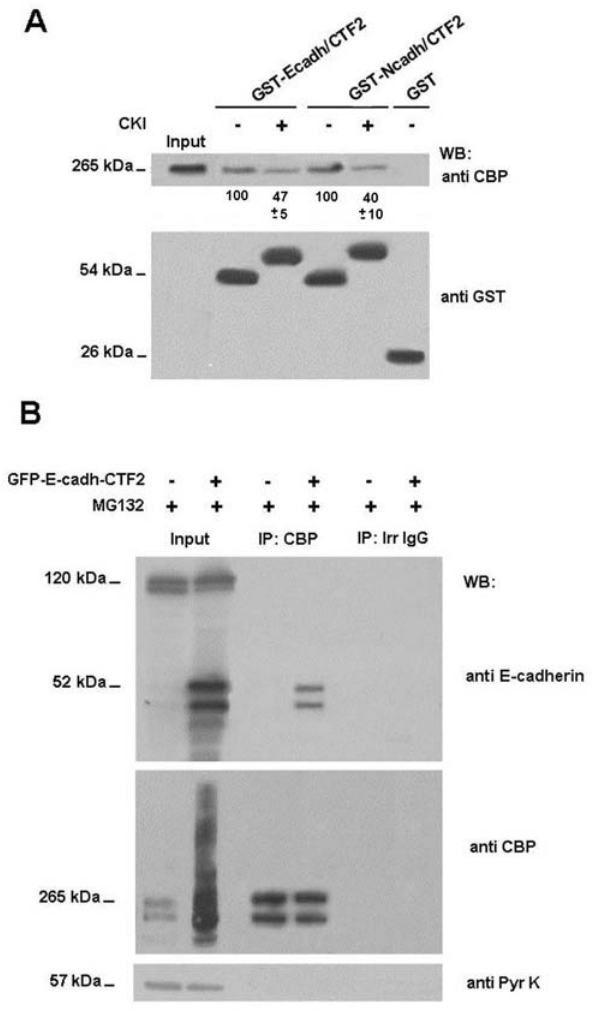
Figure 7. The CTF2 fragment of E-cadherin interacts with CBP. (A) GST-E-cadh-CTF2 and GST-N-cadh-CTF2 were phosphorylated with CKI d , as described in Material and Methods . 20 pmols of non-phosphorylated or phosphorylated GST-cadh-CTF2 proteins, or GST as a control, were incubated with 1.2 mg of MEF PS ( 2 / 2 ) total cell extracts. Protein complexes were affinity-purified with glutathione-Sepharose and ana- lyzed by SDS-PAGE and Western blotting with anti-CBP and anti-GST, to ensurethat similar levels offusionproteinswerepresent inall cases.Inthe Input lane,a sample correspondingto5%of the total cell extracts usedfor the assay was loaded. Autoradiograms were scanned and the average of CBP bound with respect to the value obtained without CKI is shown below the western blot (average + / 2 S.D. of three experiments). (B) MEFs PS ( 2 / 2 ) were transfected with 7 m g of GFP or E-cadh-CTF2-GFP, to simulate the CTF2 fragment present in MEF PS1/PS2 ( + / + ). After 24 h expression, cells were treated with the proteosome inhibitor MG132 at 30 m Mfor 4h.RIPAbuffer was used toobtaincytosoliccellfraction. For theIP, 500 m g of the cytosolic fraction were incubated with 2.5 m g of anti CBP antibody to a final lysate concentration of 1 m g/ m l. 30 m g of cytosolic cell lysates were loaded for inputs. affected cell proliferation: whereas MEF( 2 / 2 ) cells expressing npPS1 proliferated at a rate 38% of control cells, those expressing pPS1 did it at a 60% (Figure 9A). Since c-myc is a well-established target of b -catenin ? Tcf-4 transcriptional activity [23,47], we